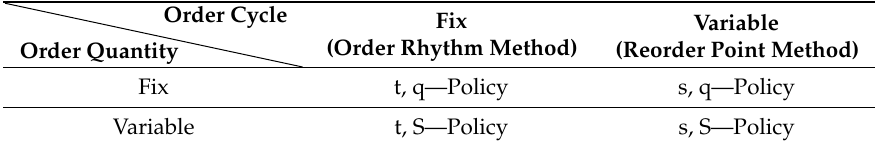
Table 5. Overview of the possible ordering policies (own elaboration based on